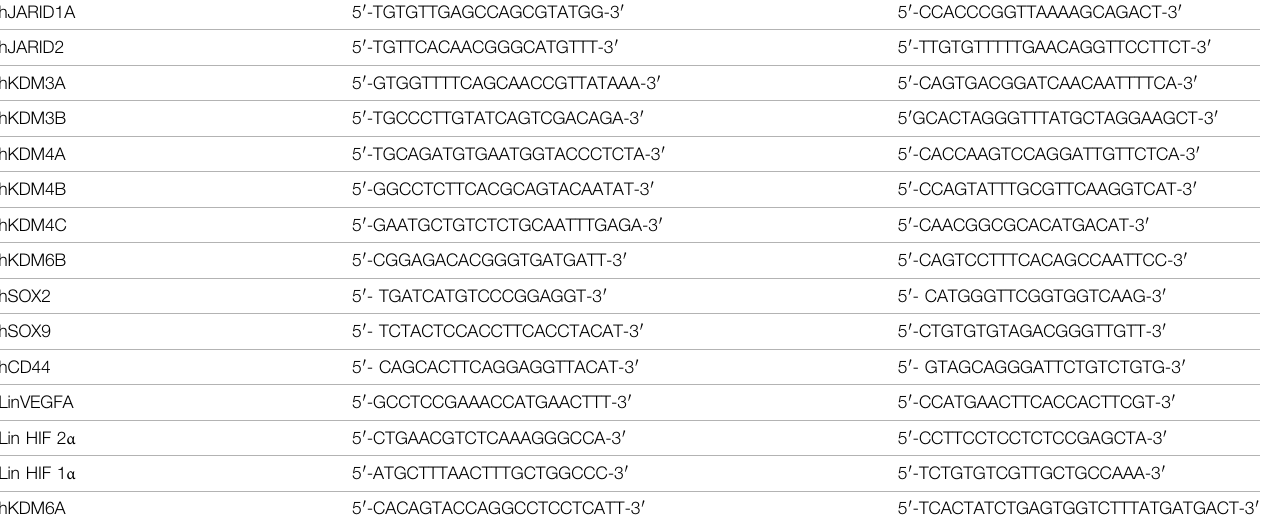
TABLE 1 | List of primers for real-time